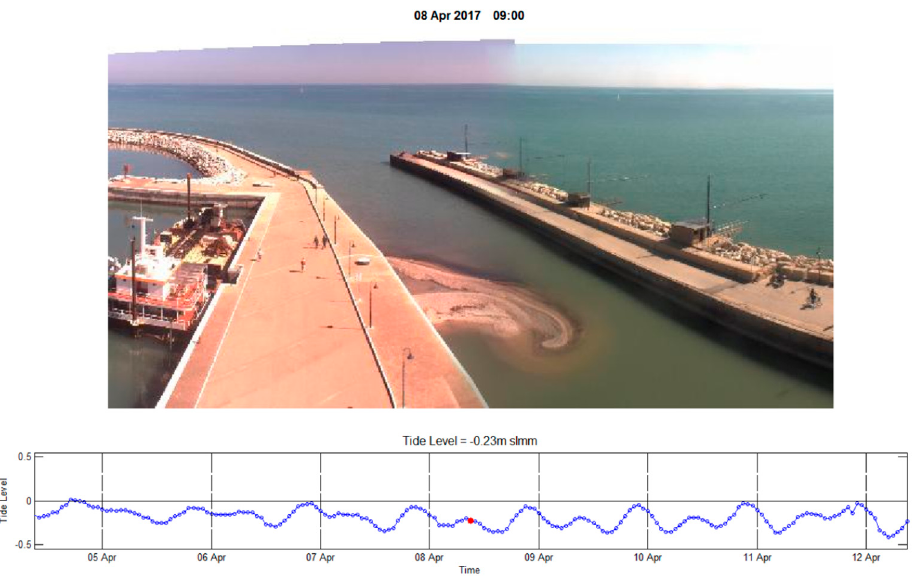
Figure 6. Illustration of sedimentary deposition creating an internal mouth bar at the final reach of the Misa River. The lower panel gives the tidal